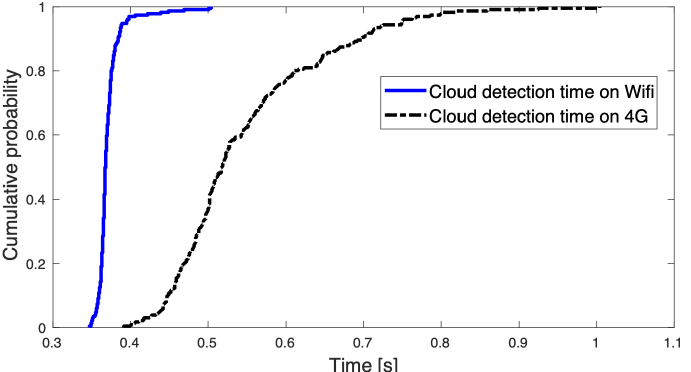
Figure 10. Cloud detection time on 4G and Wi-Fi